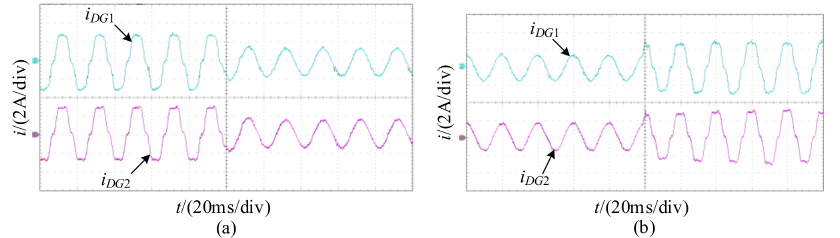
Figure 17. Experimental results of the proposed method under load changing conditions: ( a ) nonlin- ear load access to PCC and ( b ) nonlinear loads disconnected from